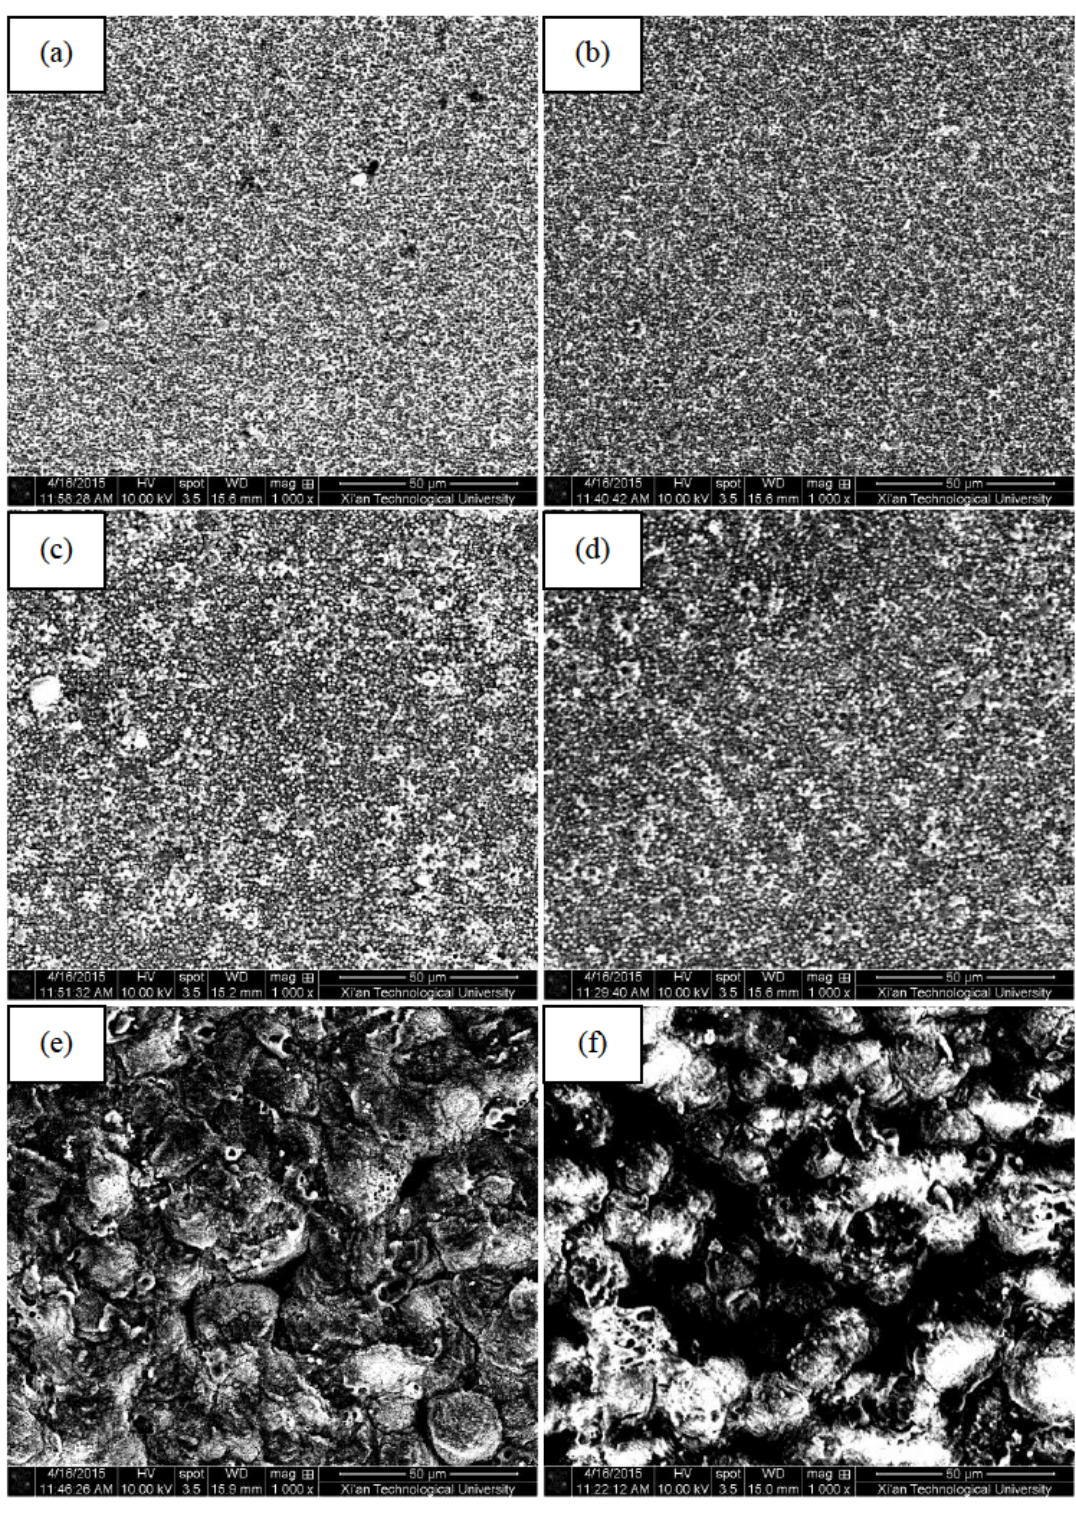
Figure 1: Surface morphologies of MAO coatings before and after heat treatment (a) MAO-1, (b) MAO-1+HT, (c) MAO-2, (d) MAO-2+HT, (e) MAO-3, (f)